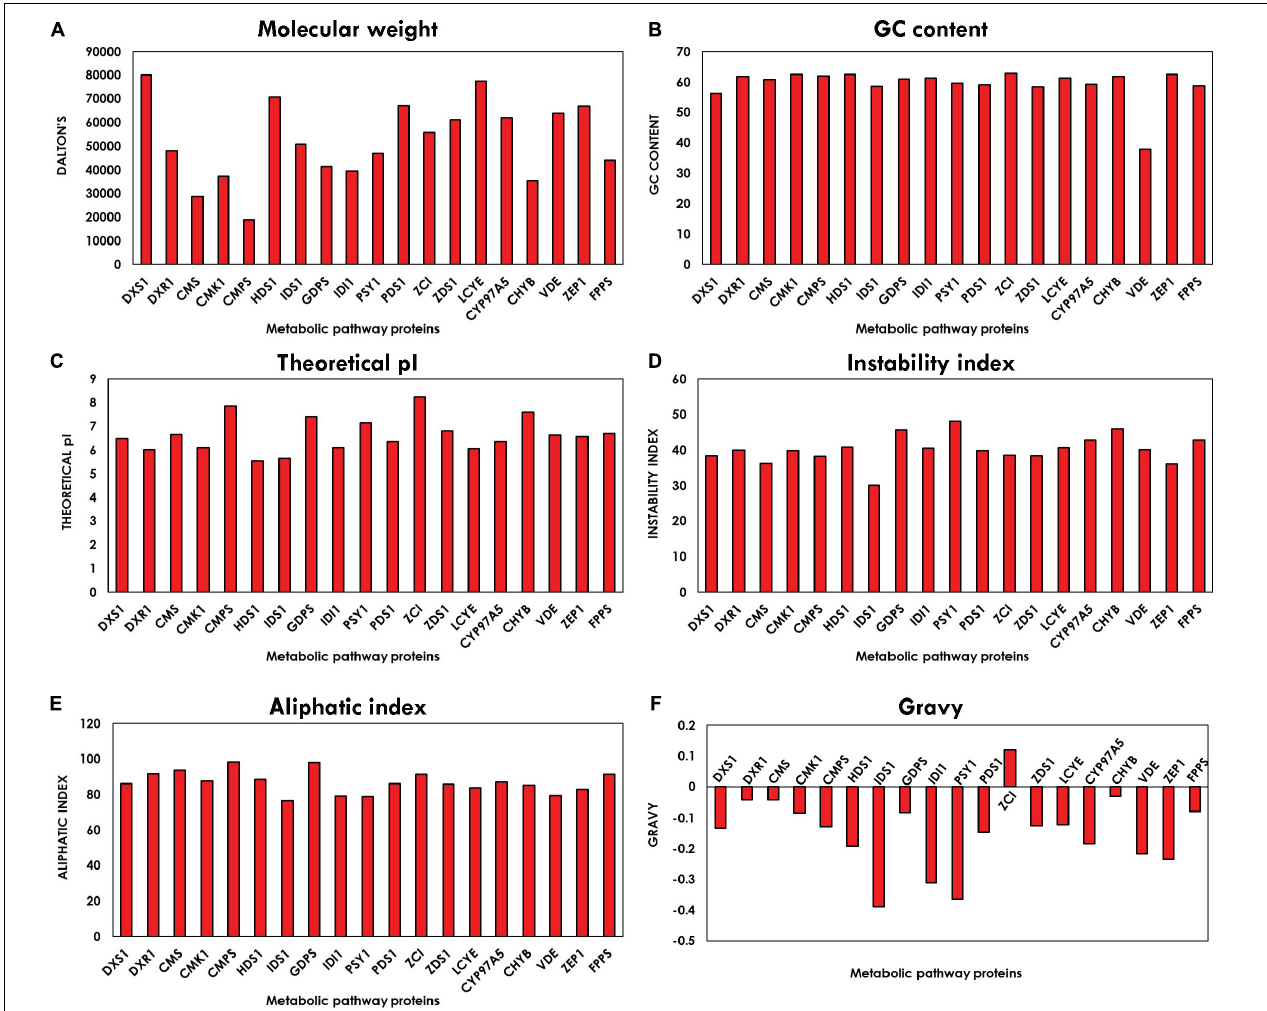
FIGURE 3 | Bar plot depicting physico-chemical characteristics: (A) molecular weight (B) , guanine–cytosine (GC) content, (C) isoelectric point (pI), (D) instability index, (E) aliphatic index, and (F) grand average of hydropathy (GRAVY) index of methyl erythritol phosphate (MEP) pathway genes using ExPASy-ProtParam